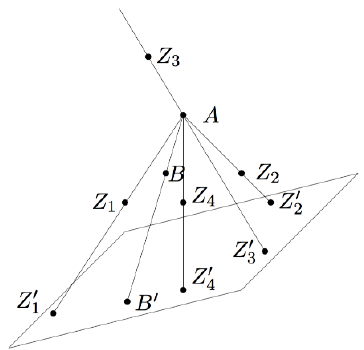
Figure 7 . Projecting through A to get a two-dimensional con(cid:12)guration.